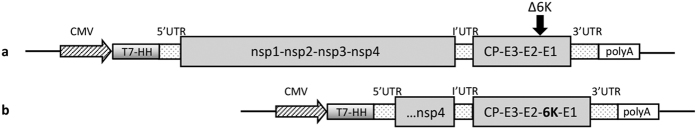
Organization map of SAV3 cDNA in plasmids.(a) SAV3 6K-deleted cDNA plasmid (FL-∆6K): the entire 6K gene was removed from SAV3 full-length genome. (b) Helper cDNA plasmid (Helper-6K): 100 bases of nsp4 C-terminal together with the whole 26S subgenome containing 6K gene were included in the helper plasmid. HH: hammerhead ribozyme sequence, a self-cleavage ribozyme providing the exact 5′ viral end after RNA transcription from cDNA plasmid.